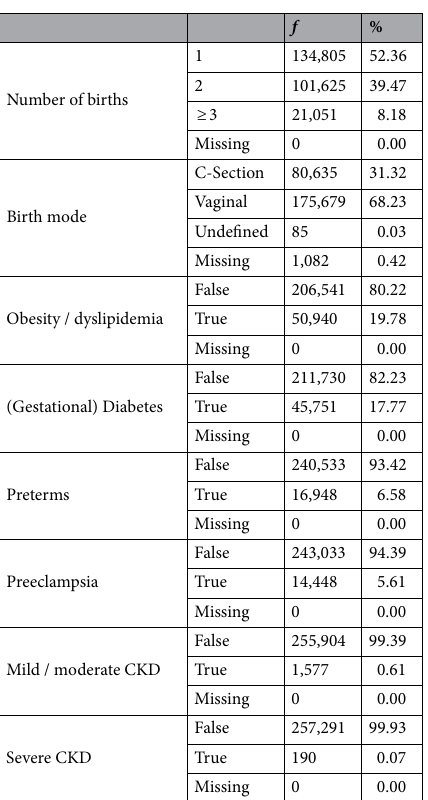
Table 2. Sample characteristics. f = frequency; % = percentage of N =